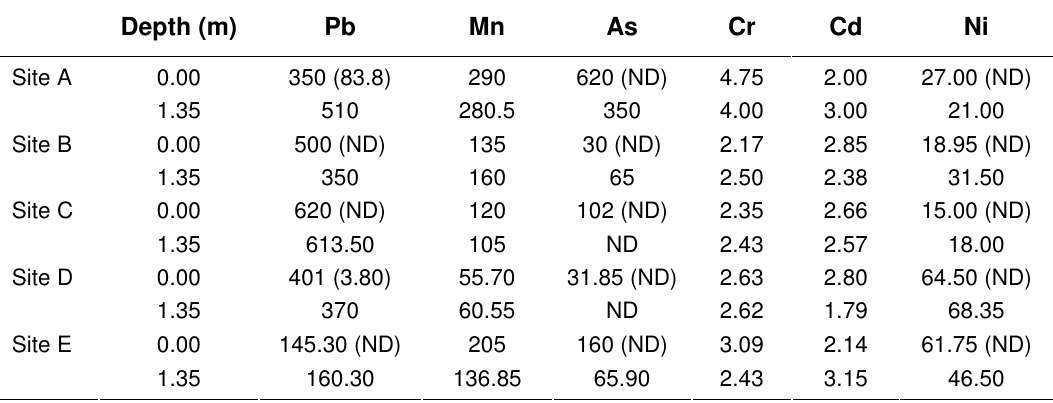
Metal Levels in mg/kg of Soil at Different Dump